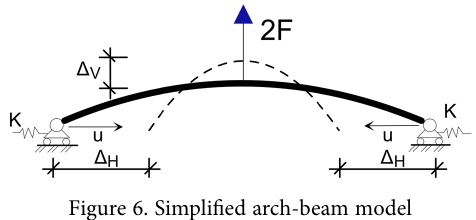
Figure 6. Simplified arch-beam model